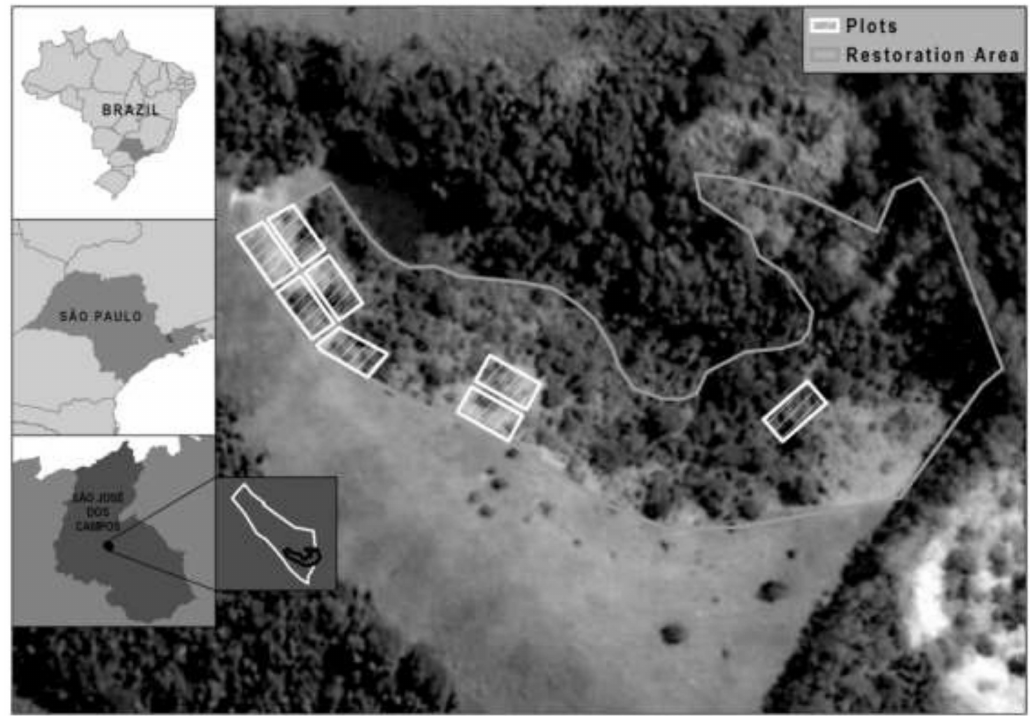
Figure 1. Satellite image of the study site, inside S ã o Jos é dos Campos municipality, S ã o Paulo state,